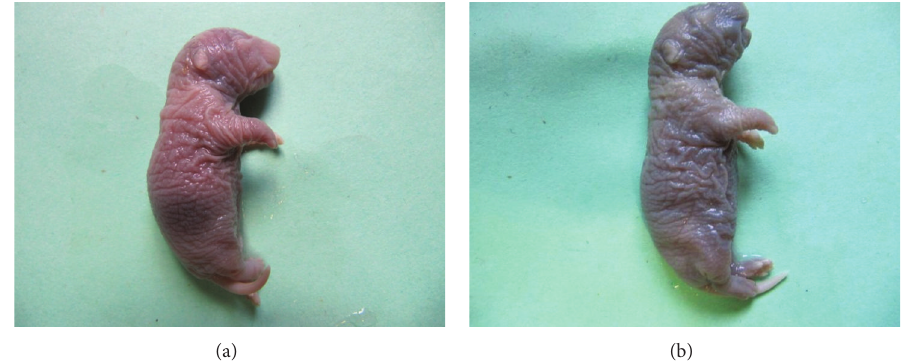
Figure 1: Macroscopic view of 17 days fetuses of control (a) and the group received high doses of fluoxetine and olanzapine (b). In the control group fetus, the body is C-shaped and upper and lower extremities are in their normal locations (a). In the fetus from the group that received high doses of fluoxetine and olanzapine, the body is not fully C-shaped and the forelimbs are not symmetrical (b).